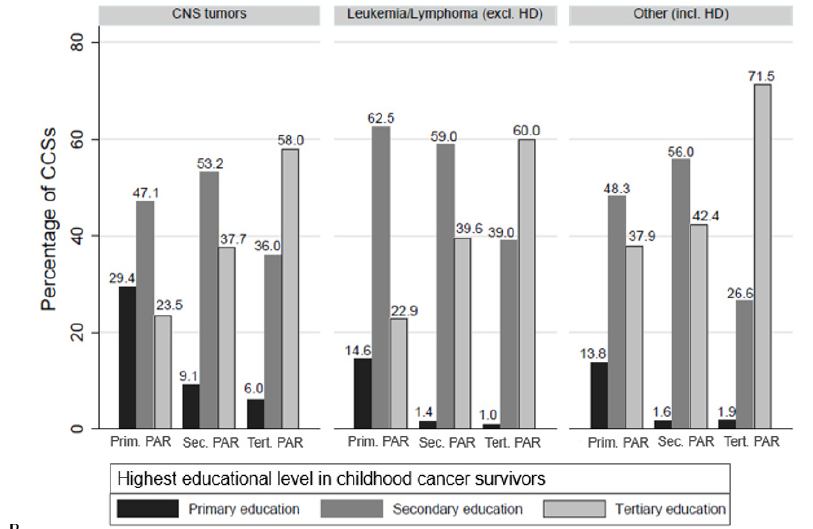
Figure 2. Highest educational level in childhood cancer survivors, represented as bars, stratified by highest parental (PAR) education and by diagnostic group; ( A ) all survivors (n = 2016), ( B ) survivors ≥ 25 years (n = 968). Abbreviations: HD = Hodgkin disease/lymphoma; Prim. PAR = primary education in parents; Sec. PAR = secondary education in parents; Tert. PAR = tertiary education in parents; HD = Hodgkin disease/lymphoma, PAR = parents; CCSs = childhood cancer survivors. Table 3. Multivariate regression analysis evaluating the association between highest parental educational level and highest educational level achieved in childhood cancer survivors aged ≥ 25 years at survey, stratified by diagnostic group. Coefficient 95%CI p -Value All survivors aged ≥ 25 years (n = 1044)